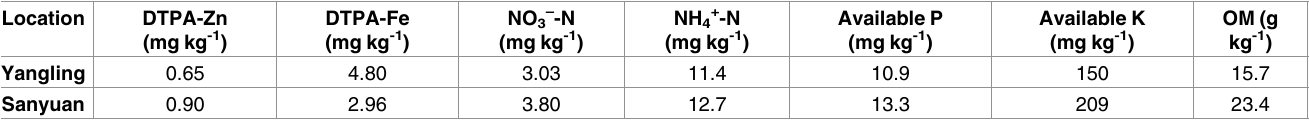
Table 1. Selected soil properties of the experimental sites at Yangling and Sanyuan.